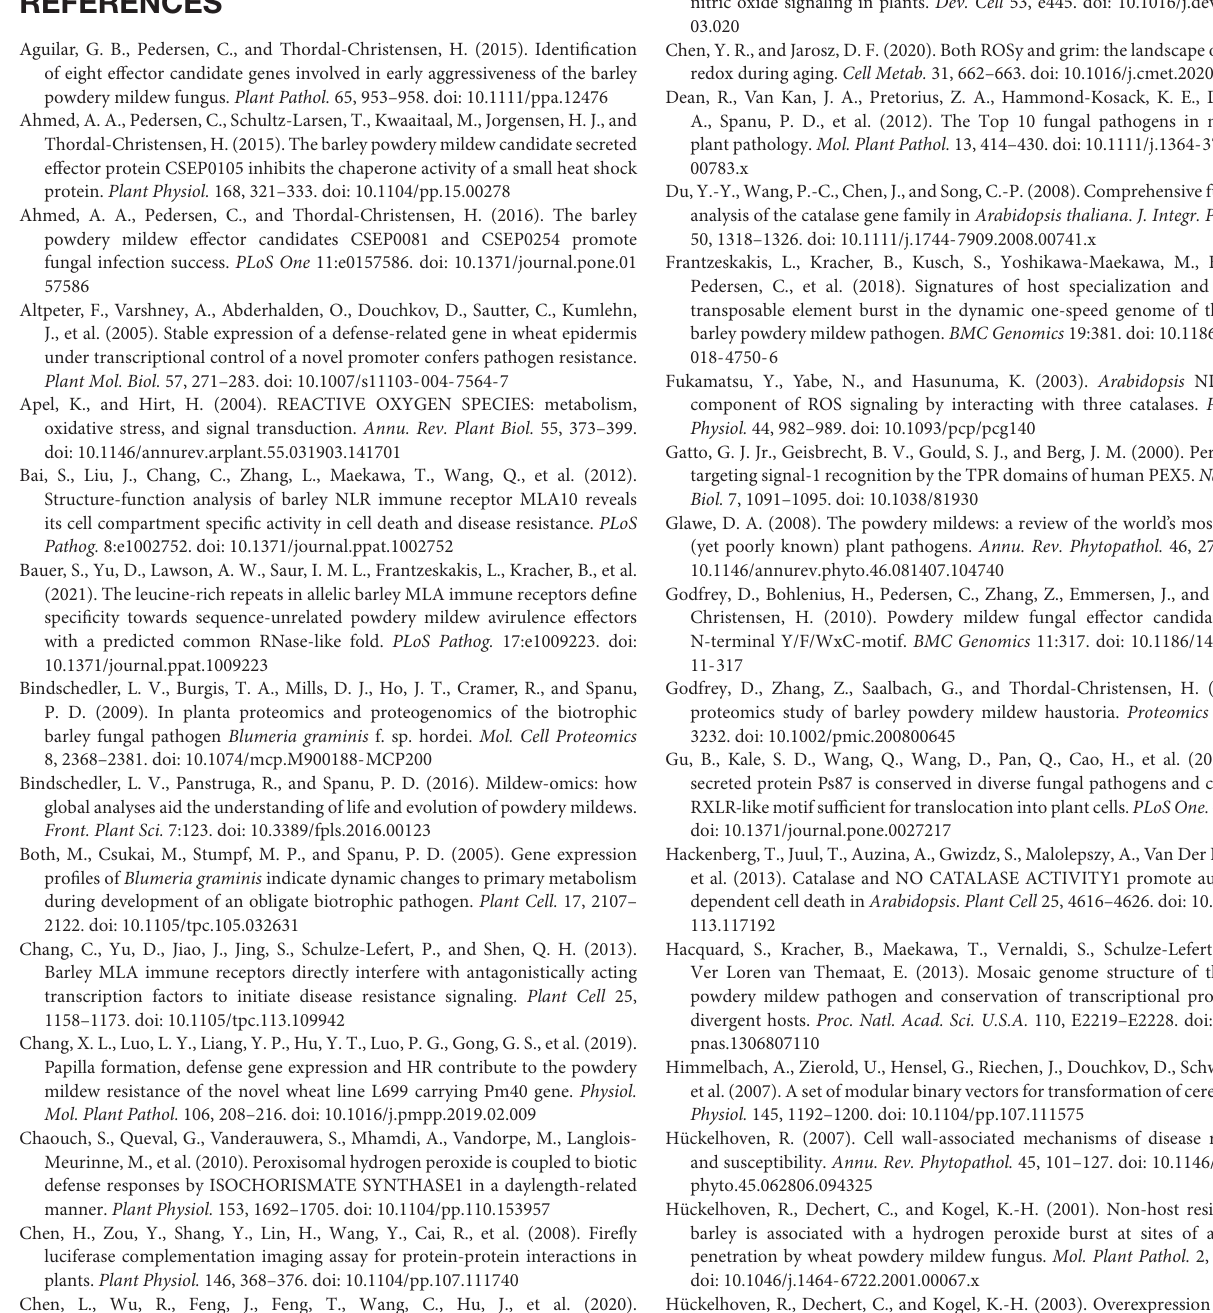
and Hv CAT1-CT (402–492) used in the Y2H assay. Catalase core domain and catalase-related immune responsive domain (catalase-rel) are indicated. (B) Y2H analysis of the interaction between NT- or CT-fragments of Hv CAT1 and CSEP0027. Yeast was transformed with the indicated bait and prey constructs. Serial dilutions from cell suspension of yeast expressing bait and prey constructs are shown. Growth on SD-Leu-Trp plates indicates yeast clone carrying bait and prey constructs. Interactions were detected on SD-Leu-Trp-His- Ade